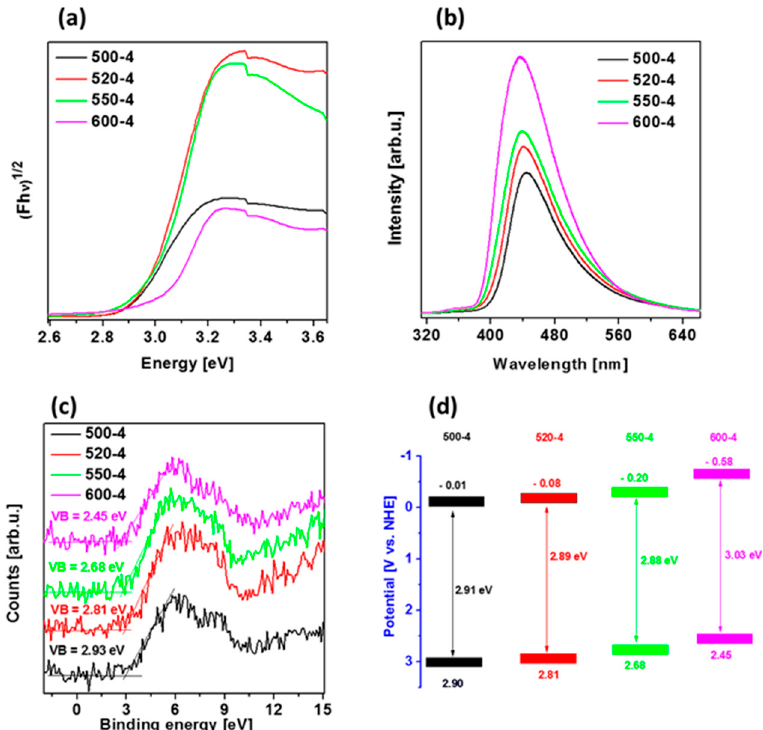
Figure 4. ( a ) Diffuse reflectance spectra (DRS) spectra, ( b ) photoluminescence (PL) spectra, ( c ) va- lence band (VB) X-ray Photoelectron Spectroscopy (XPS) spectra, and ( d ) band diagrams of poly- meric carbon nitride prepared under different temperatures (500–600 °C) with heating rate of 4